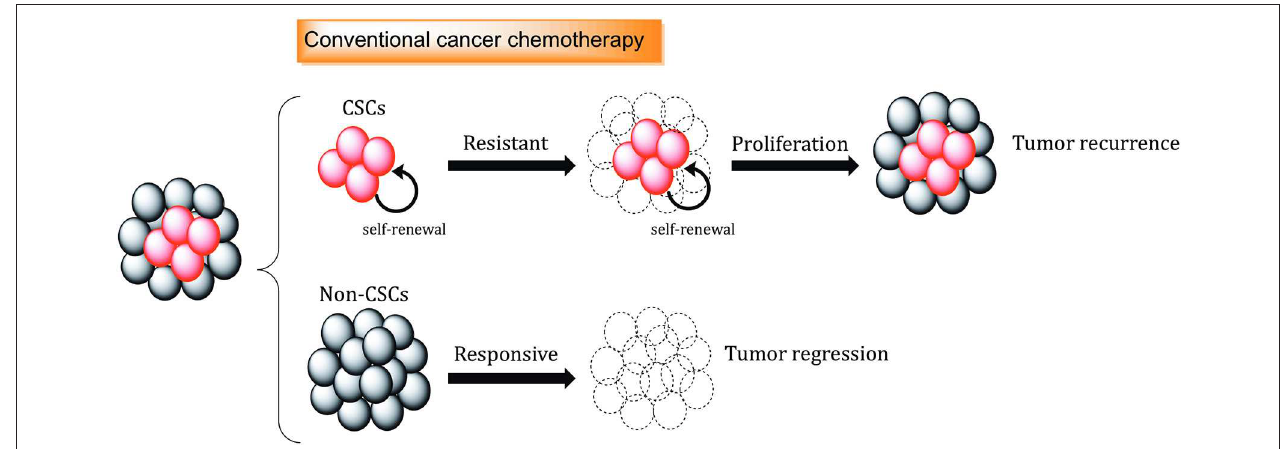
FIGURE 2 | The role of cancer stem cells in drug resistance. Standard chemotherapeutics are not able to kill cancer stem cells (CSCs), which can promote tumor regrowth and eventually result in disease relapse. Different mechanisms, including increased.